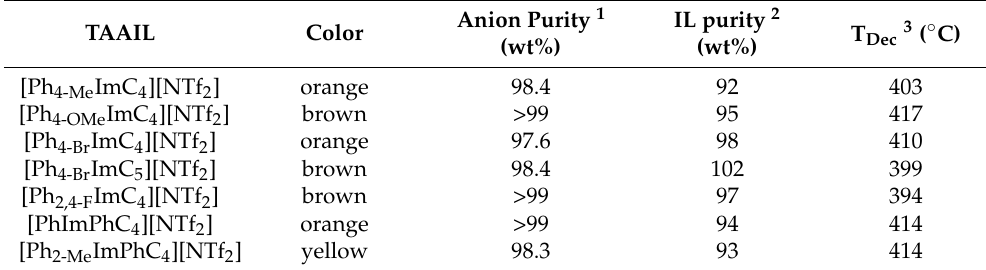
Table 1. Anion purity, IL purity, and decomposition temperature of TAAILs utilized in this work. TAAIL